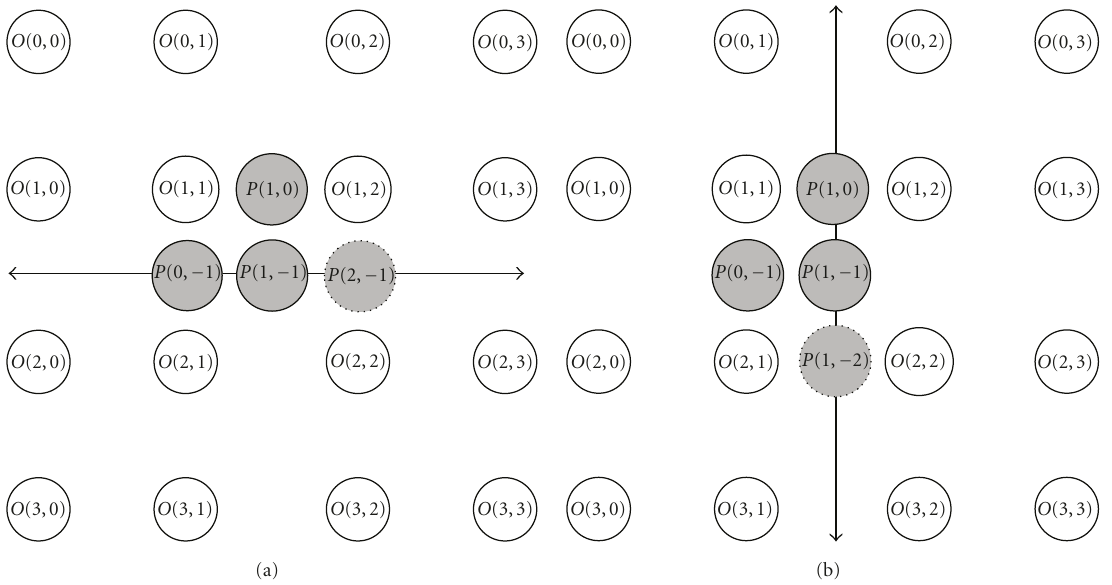
Figure 6: The supplementary pixels without reference pixels along the edge direction for (a) the 0 degree edge and (b) the 90 degree edge.